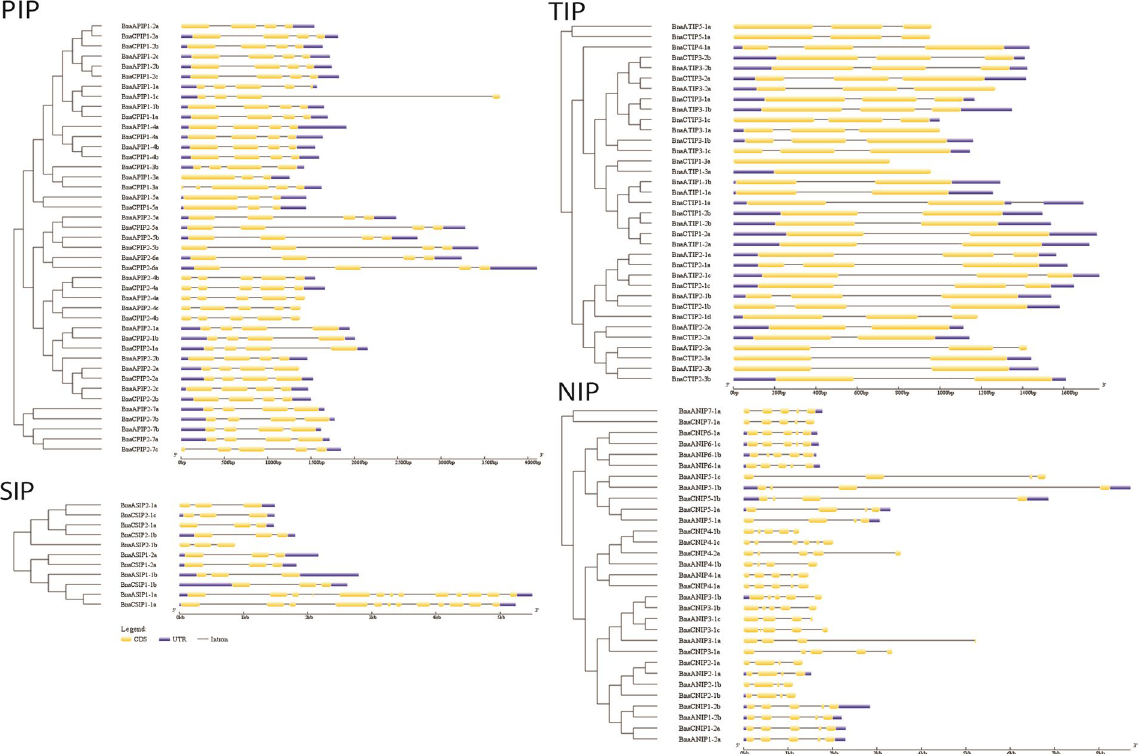
Figure 4. Intron-exon structure and organization of canola aquaporin genes. Aquaporins were categorized into PIP (plasma membrane intrinsic protein), TIP (tonoplast intrinsic proteins), NIP (NOD26-like intrinsic proteins), SIP (small basic intrinsic